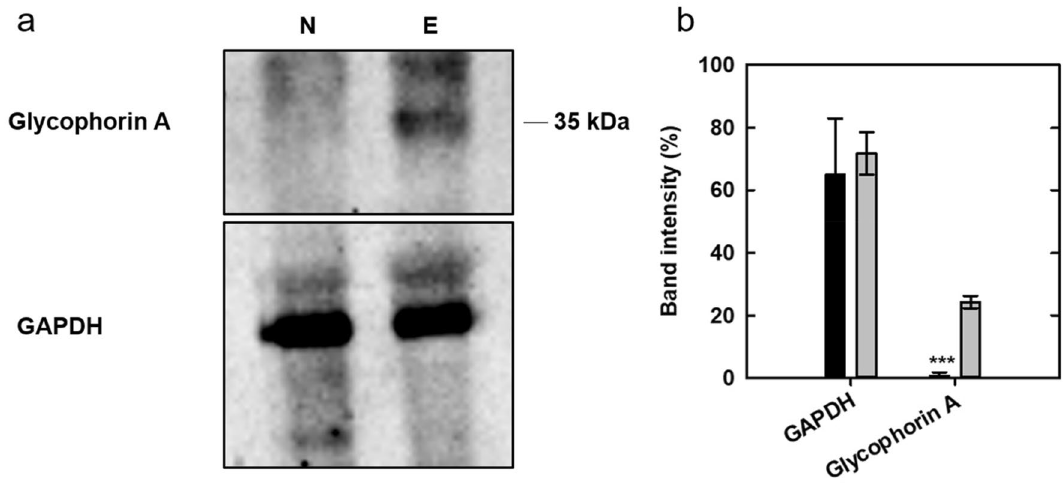
Figure 4. ( a ) Cropped bands of WB probed with anti-Glycophorin A antibody (upper panel) of the extracts from ecchymotic (E) and normal (N) tissue pools from individuals 13–18. GAPDH was used as a loading control (lower panel) on the same samples. Original full-length blot images and both replicates used for the analysis are provided in Supplementary Fig. S3. ( b ) Densitometric analysis of the WB in the extracts from ecchymotic (grey) and normal (black) tissue pools. Data are mean ± standard deviation from two different gels. *** p < 0.001 ecchymotic versus normal skin.